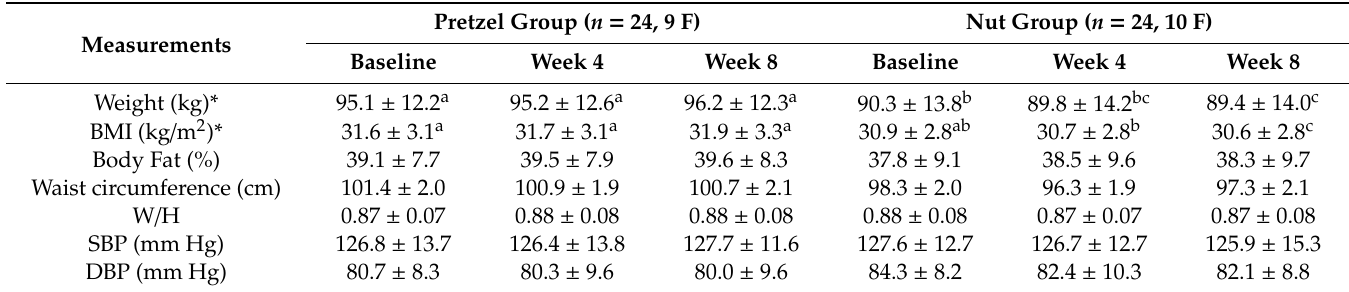
Table 1. Anthropometrics and blood pressure measured at baseline, week 4, and week 8 in the pretzel and nut groups. Measurements